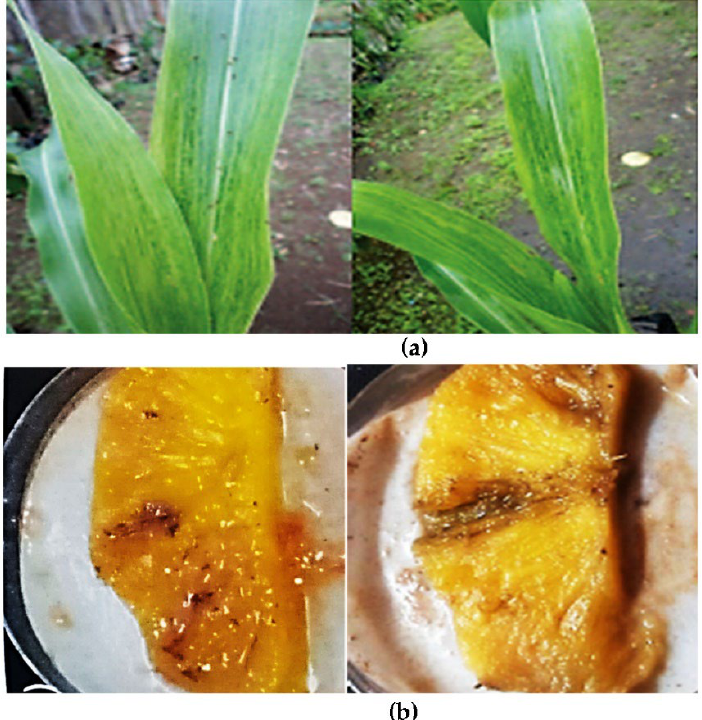
Figure 2. ( a ) Corn plant and ( b ) pineapple fruitlet inoculated with jackfruit-bronzing bacterium P. stewartii subsp. stewartii showing typical leaf blight symptoms and localized lesions [24]. Adapted with permission from [21].